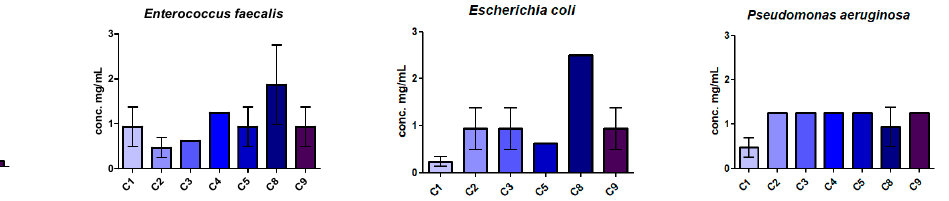
Figure 6. Antibiofilm activity of the employed compounds.